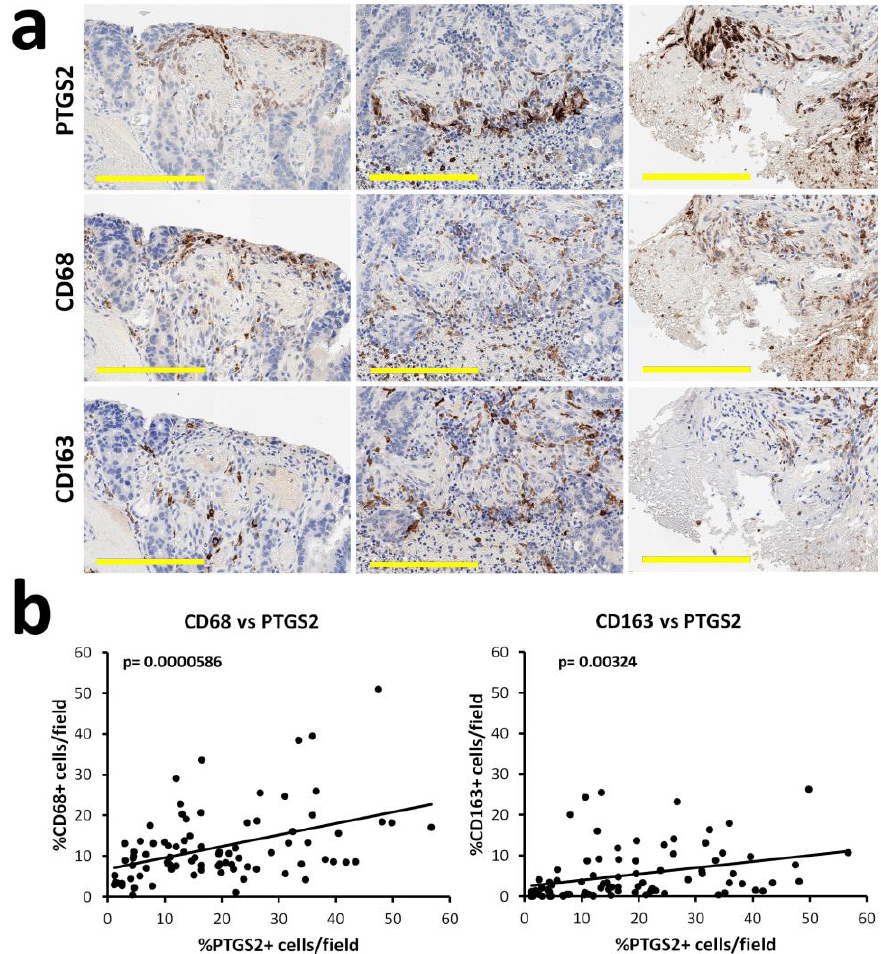
Figure 3. Analysis of PTGS2 influence on CD68 and CD163 macrophage populations on CRC serial sections: ( a ) Representative images of PTGS2, CD68, and CD163 staining on serial sections: PTGS2 can be found in areas enriched with CD68-positive macrophages, but it shows infrequent overlapping. Scale bar = 200 µ m; ( b ) Digital pathology quantification of PTGS2, CD68, and CD163-positive cells on overlapping areas of serial sections and plot of linear regression. PTGS2 showed a partial relation with CD68-positive macrophages and a weak relation with the CD163